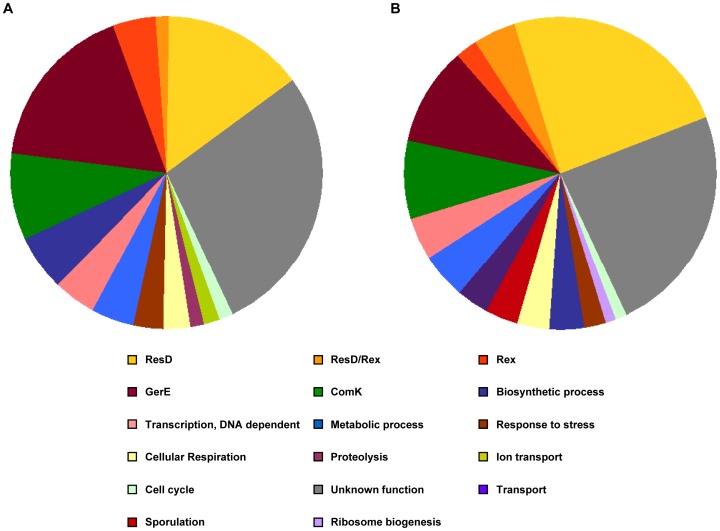
Functional classification of mRNAs with altered abundance in B. subtilis strain 168Δhfq.(A) Gene transcripts significantly altered during logarithmic phase. (B) Gene transcripts significantly altered during early stationary phase. Genes are classified either according to their regulon affiliation (for the regulons ResD, Rex, GerE and ComK) or according to gene ontology (restricted to the terms within the domain “biological process”).